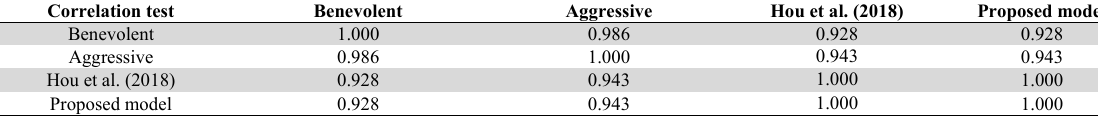
Spearman’s rank correlation test for six nursing homes Correlation